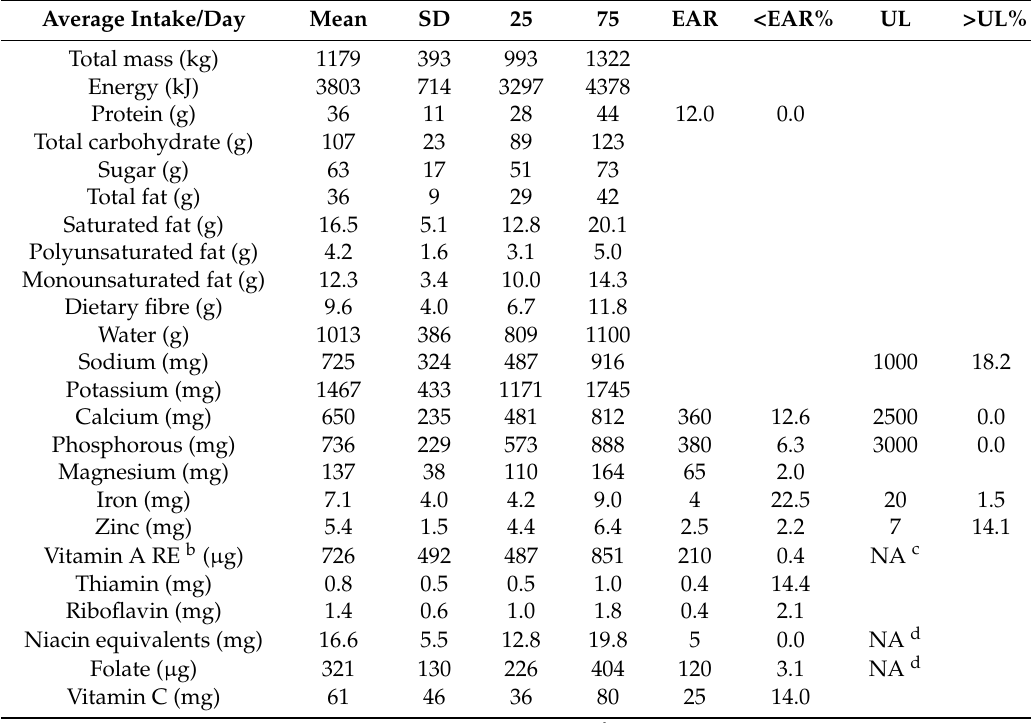
Figure 2. Frequency of intake of zinc ( n = 714) showing estimated average requirement (EAR = 2.5 mg) and upper limit of intake (UL = 7 mg). Table 2. Nutrient intakes of children a (mean age 13.1 months) and comparison with selected Nutrient Reference Values for children aged 1–3